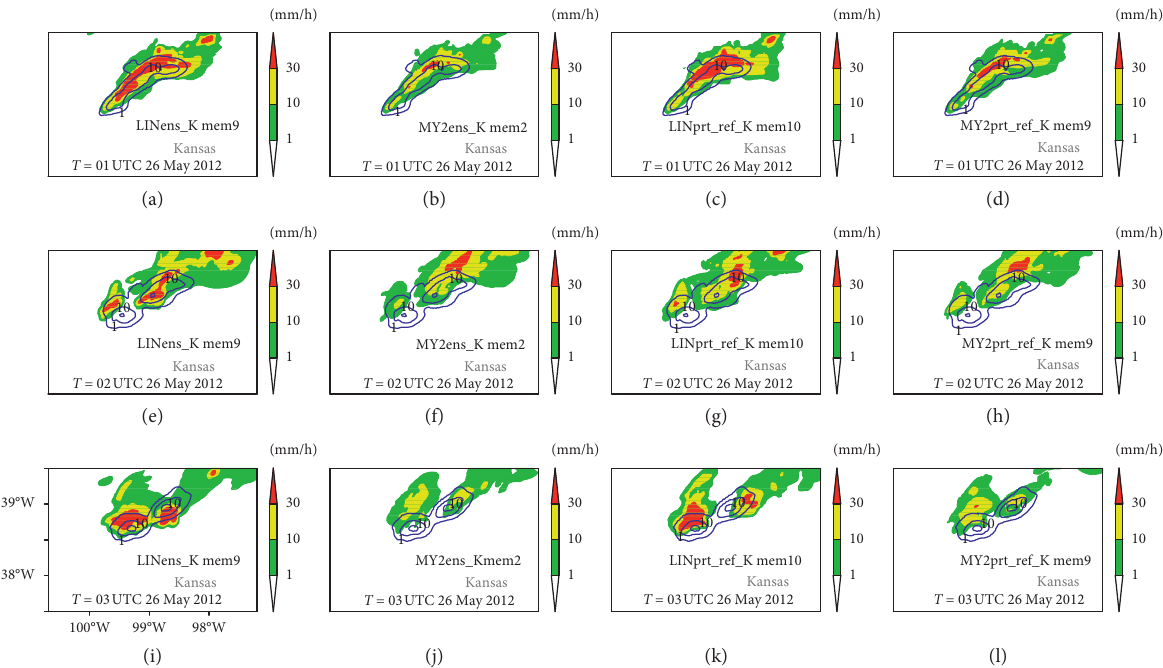
Figure 10: The same as in Figure 7, except for (a, e, i) LINens_K, (b, f, j) MY2ens_K, (c, g, k) LINprt_ref_K, and (d, h, l)